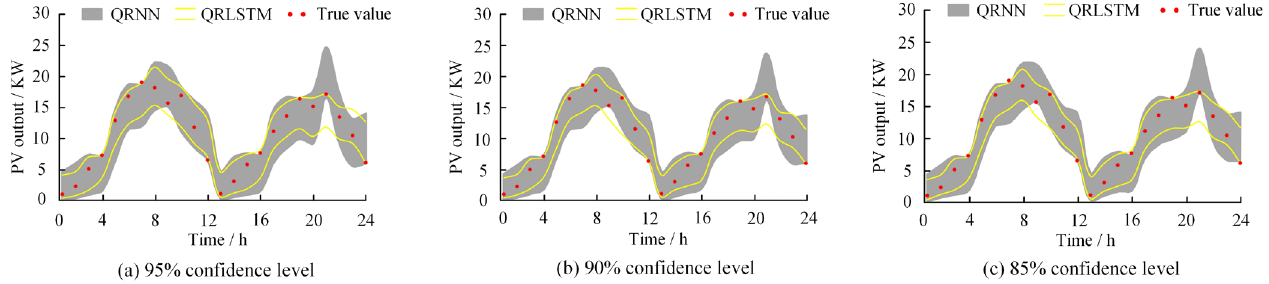
Figure 6. Comparison of interval prediction results on similar-day 2.